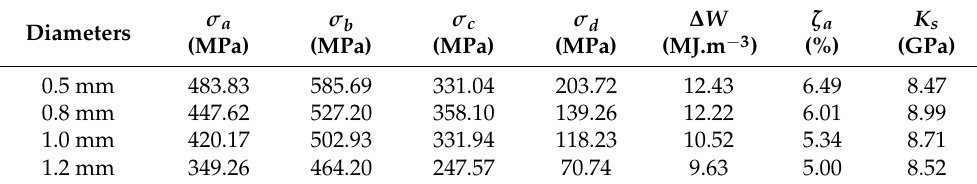
Figure 5. Stress-strain curve of austenite SMA wire with different diameters. Table 4. Mechanical properties of SMA wires with different diameters.